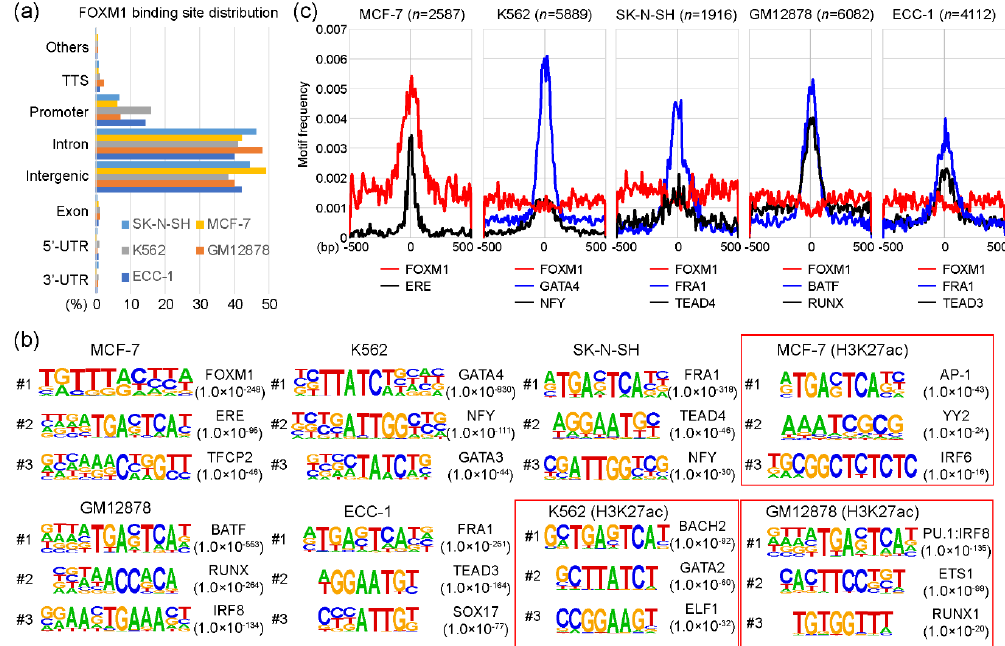
Figure 1. FOXM1 (Forkhead box protein M1) binding motif analysis. ( a ) Distributions of FOXM1 binding sites in SK-N-SH, MCF-7, K562, GM12878, and ECC-1 cell lines are shown, according to transcription termination site (TTS), promoter (+/ − 2kb of the transcription start site), intron, intergenic, exon, 5 ′ -unstranslated region (5 ′ -UTR), and 3 ′ -UTR. ( b ) Top three motifs identified with FOXM1 binding sites in a given cell line are shown. H3K27ac-enriched regions were used as control sets for the motif analysis of MCF-7, K562, and GM12878 cell lines (red boxes). ( c ) Motif frequencies of the top two motifs in each cell line were plotted according to the center of FOXM1 binding peaks.